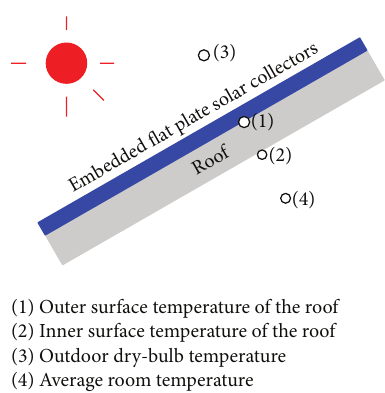
Figure 11: Roof temperature measurement points for the installed flat plate solar